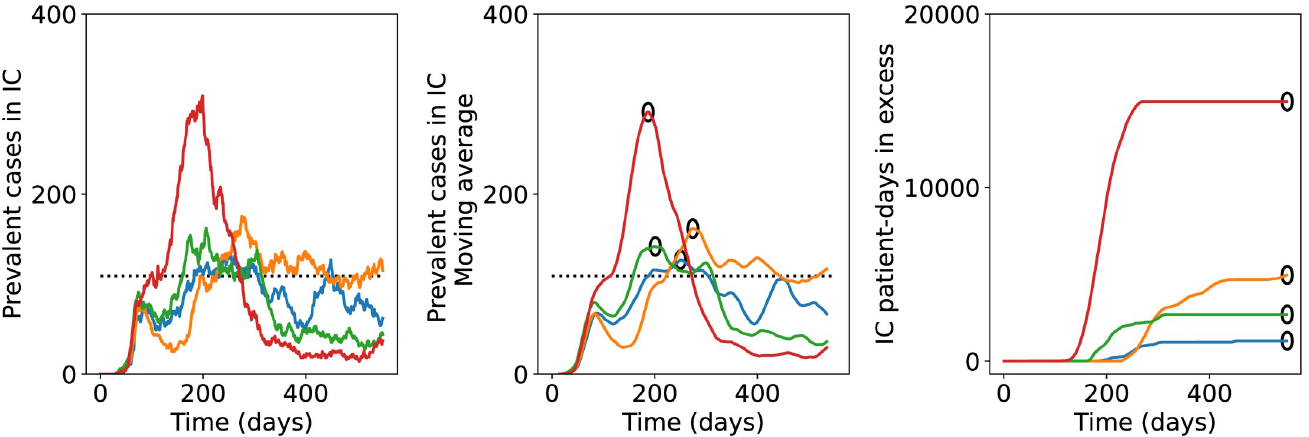
Fig 1. Examples of model outcomes for four independent simulations of the Phased Opening strategy with different policy-related parameters. Left: time series of the prevalent cases in intensive care. Middle: the resulting moving average of the number of IC prevalent cases. Right: the corresponding time series of the total number of IC patient-days in excess. All values on the vertical axis are per million capita. Black circles in the middle and right panel indicate the QoIs for the different simulations.